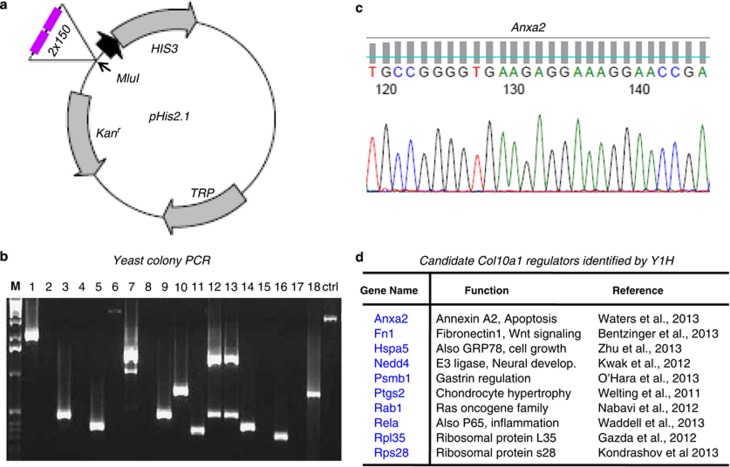
Y1H screening using the 150-bp enhancer as a bait. (a) The 150-bp Col10a1 cis-enhancer (tandem copies, 2 × 150) was cloned upstream of the nutritional reporter gene HIS3 in a pHis2.1 vector backbone (Clontech). (b) After screening a cDNA library derived from hypertrophic MCT cells, approximately 50 yeast colonies grown in selective medium and optimal 3-AT concentration were selected and subjected to PCR amplification. (c) Representative sequencing result of the PCR product shows partial sequence of exon II of gene Anxa2. (d) A list of candidate genes identified by Y1H were shown. These genes include Fn1, Hspa5, Nedd4, Psmb1, Ptgs2, Rab1, Rela, Rpl35 and Rps28. The functional description and relevant literatures were as listed